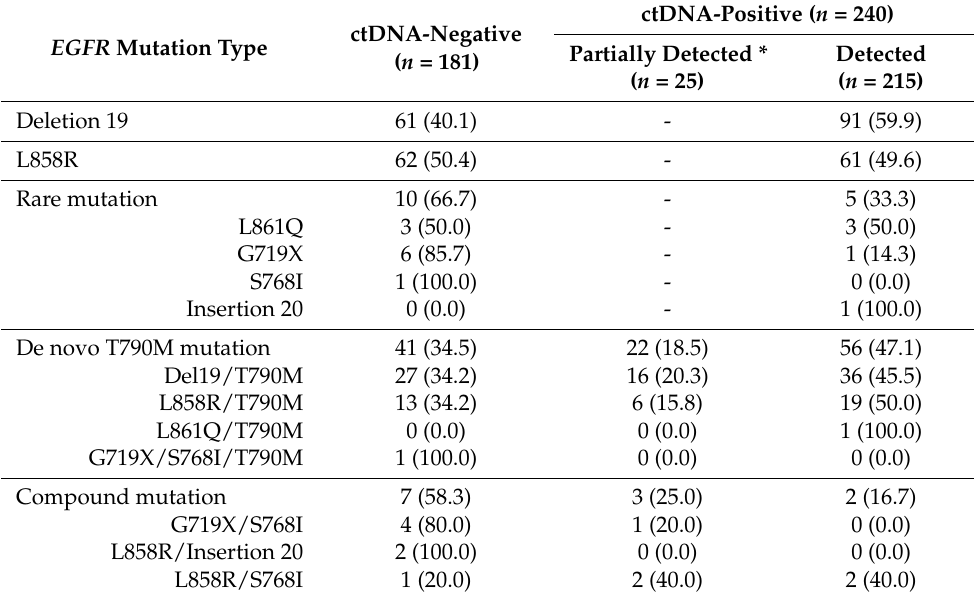
Table 2. The composition of EGFR mutation types detected by ctDNA